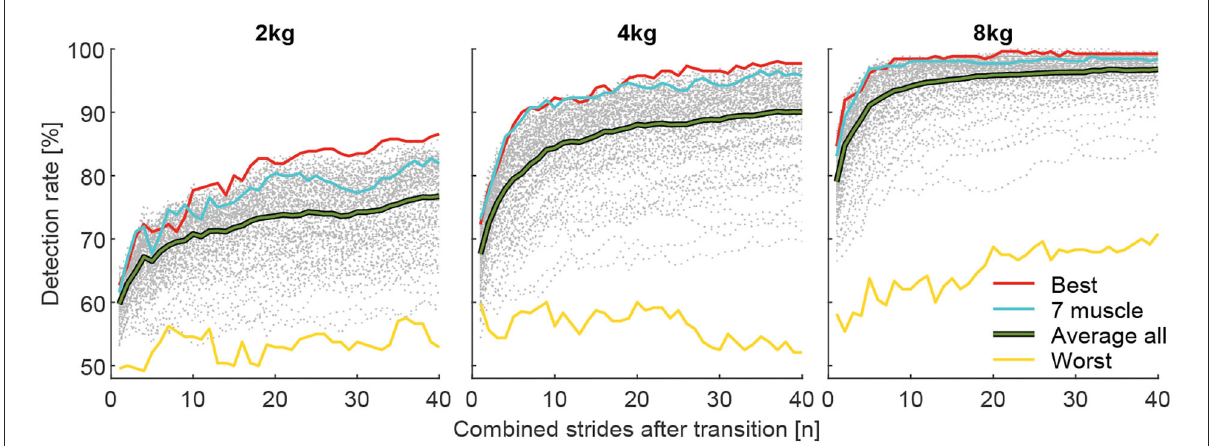
FIGURE9 Detection rates for the total carried mass of 2, 4, and 8kg for the best muscle combination (red), the seven muscle combinations (blue), the average of all combinations (green), and the worst combination (yellow). Each graph includes 40 strides in alternating order from the left (20 strides) and right (20 strides)